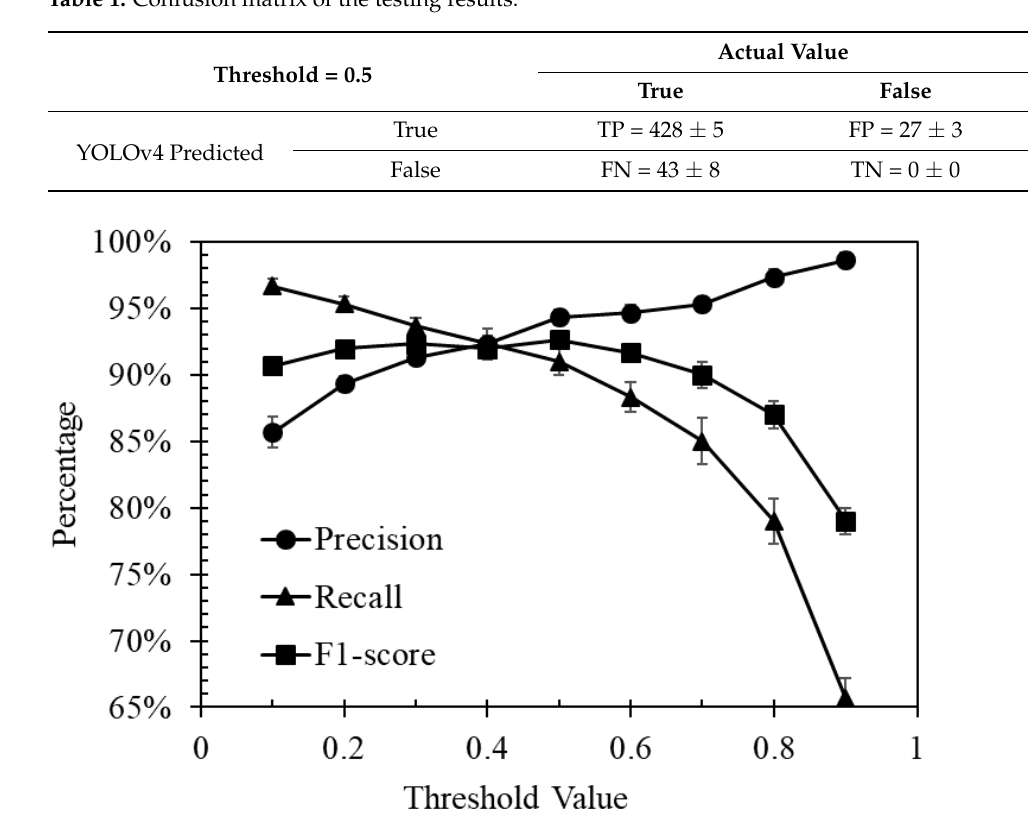
Figure 2. Evaluation metric change over threshold values.